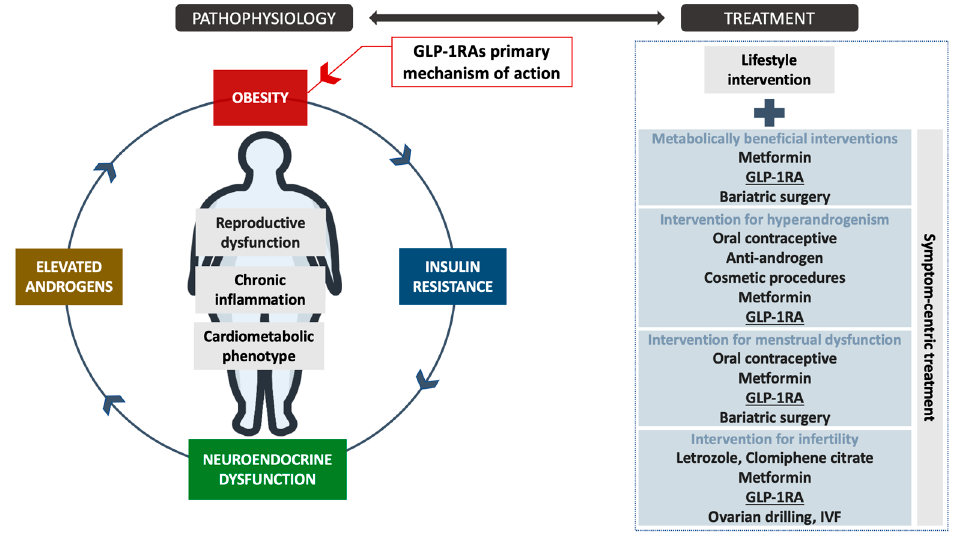
Figure 1. The potential position of GLP-1RAs in the PCOS treatment process and their mechanism of action. The high-level evidence for GLP-1RAs as anti-obesity medications is provided for populations with obesity with or without diabetes. The assessment of PCOS-specific symptom-centric treatment outcomes require future randomized control trials with well-characterized sub-phenotyping of the included cohorts. Legend: GLP-1RAs—Glucagon-like peptide-1 receptor agonists, IVF—In vitro fertilization.